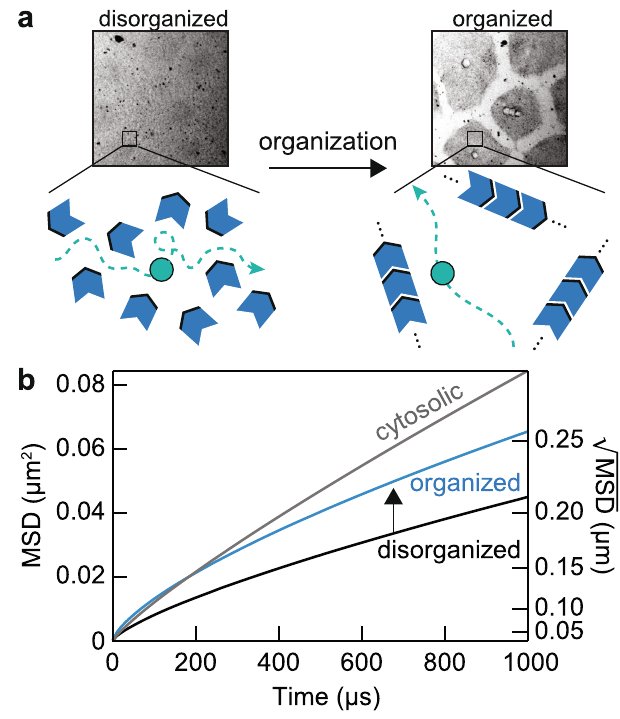
Fig. 6 | Organized cytoplasm optimizes short-range diffusion by reorganizing obstacle densities. a Schematic of the model: molecular and organelle reorgani- zation optimizes molecular diffusion by creating longer mean free paths for dif- fusing molecules. The greenobjectrepresents a protein of interest diffusing inthe cytoplasm; the blue objects represent obstacles in the cytoplasm, such as orga- nelles, cytoskeleton elements, and macromolecular complexes. In this model, proteinsinorganizedcytoplasmremainfreeto diffuseinalldirections. b Diffusion effects of molecular reorganization illustrated with mean squared displacement, MSD ( t )= Γ t α . The parameters { Γ , α } estimated for disorganized cytoplasm, orga- nized cytoplasm and the cytosol are {8, 0.75}, {8.25, 0.70}, and {30, 0.85}, respec- tively.Notethatbasedonthetradeoffbetweendiffusiontimesandsubdiffusivityin the organizing cytoplasm (Fig. 3a), we have assumed that the acceleration of pro- teinmovementsoverthesedistancescalescomesatacostofslowerdynamicsover longerdistancescales.WealsolimitthecomparisonaroundthelengthscaleofFCS measurements (~0.1 – 0.5 µ m) since protein dynamics may show distinct character- istics at shorter and longer distance scales. Source data are provided as a Source Data fi